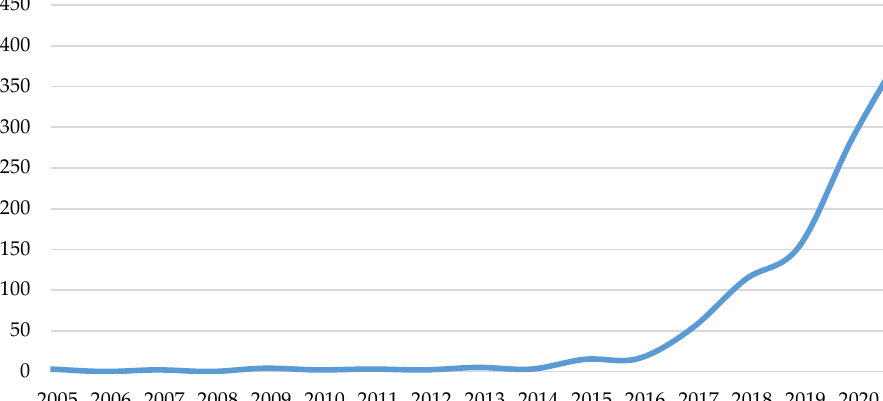
Figure 2. Number of documents published from 2005 to 2021.